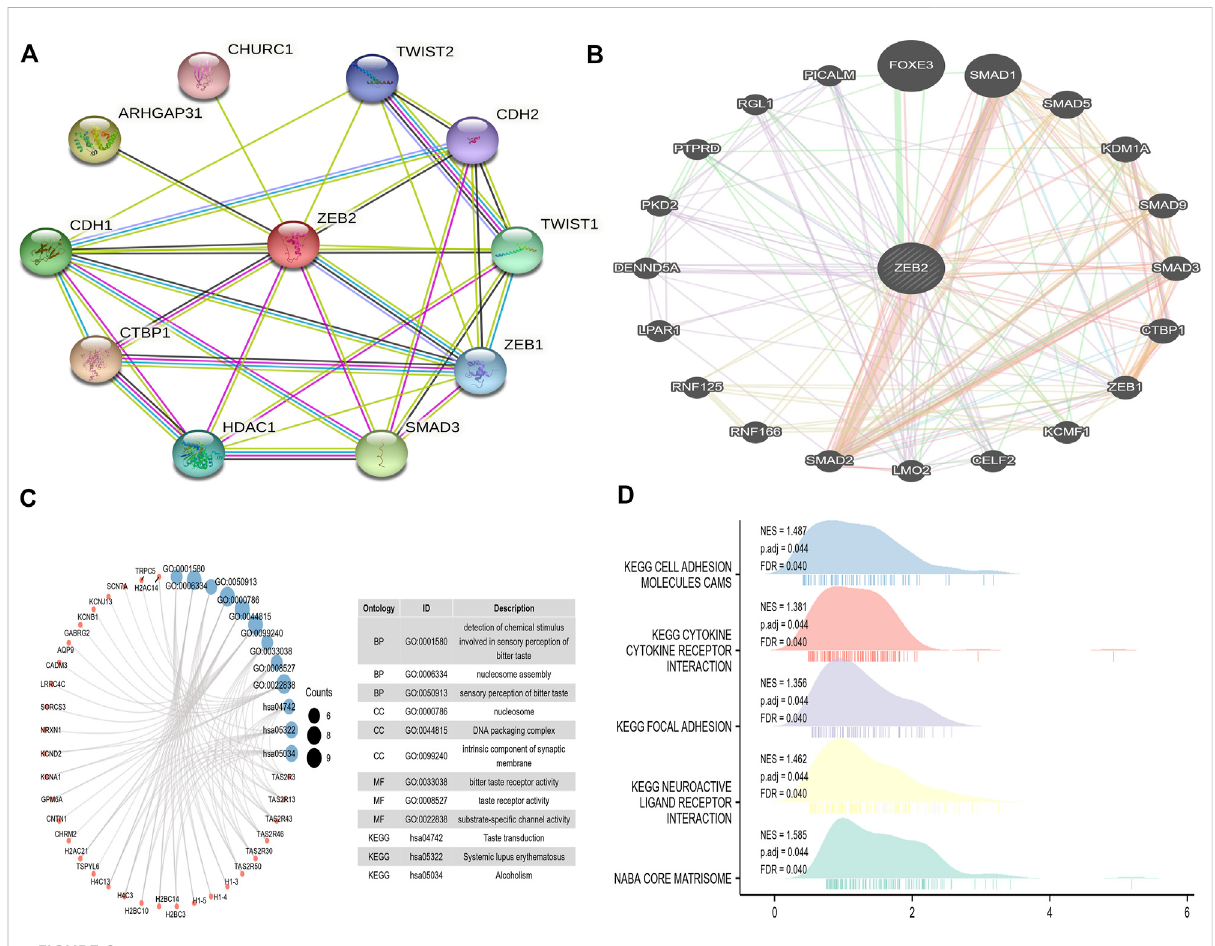
FIGURE 8 TheproteininteractionnetworkandenrichmentanalysisofZEB2. (A) ThePPInetworkontheSTRINGwebsite. (B) ThePPInetworkconstructed on the GeneMANIA website. (C) The GO/KEGG analysis of different genes. (D) The GSEA analysis of